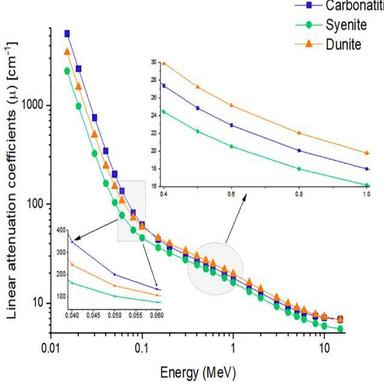
Variation of linear attenuation coefficients (µ) as a function of photon energy (MeV).